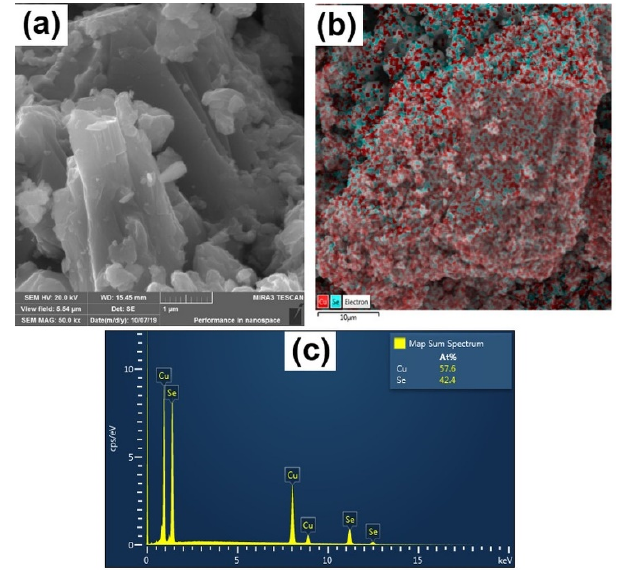
Figure 5. SEM analysis of CuSe-VM: ( a ) image; ( b ) element mapping; ( c ) EDX spectrum.